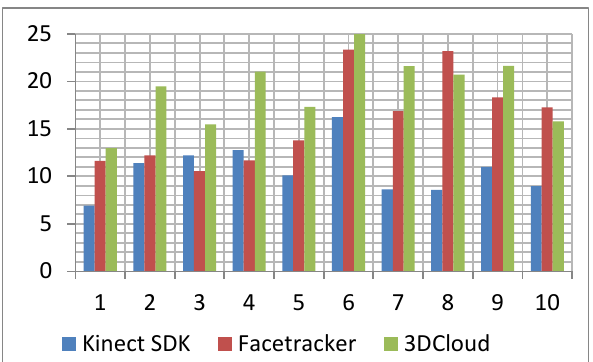
Figure 25. Mean RMSE (in degrees) for the yaw for each candidate.